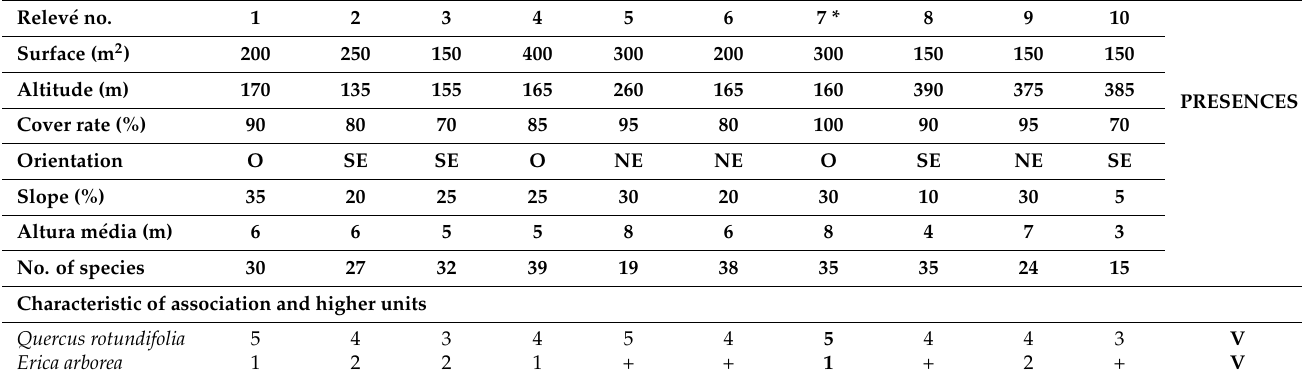
Table A3. Ulici argentei-Quercetum rotundifoliae ass. nova hoc loco (Querco rotundifoliae-Oleenion sylvestris, Oleo sylvestris-Quercion rotundifoliae, Quercetalia ilicis, Quercetea ilicis). Relev é